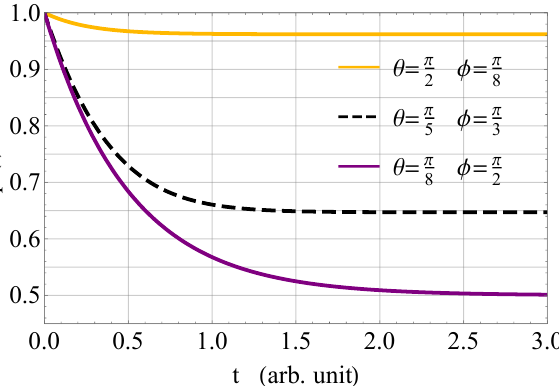
Figure 2. Plots of p ( t ) according to (20) for three combinations of θ and φ . Other parameters: γ = 1 (arb.